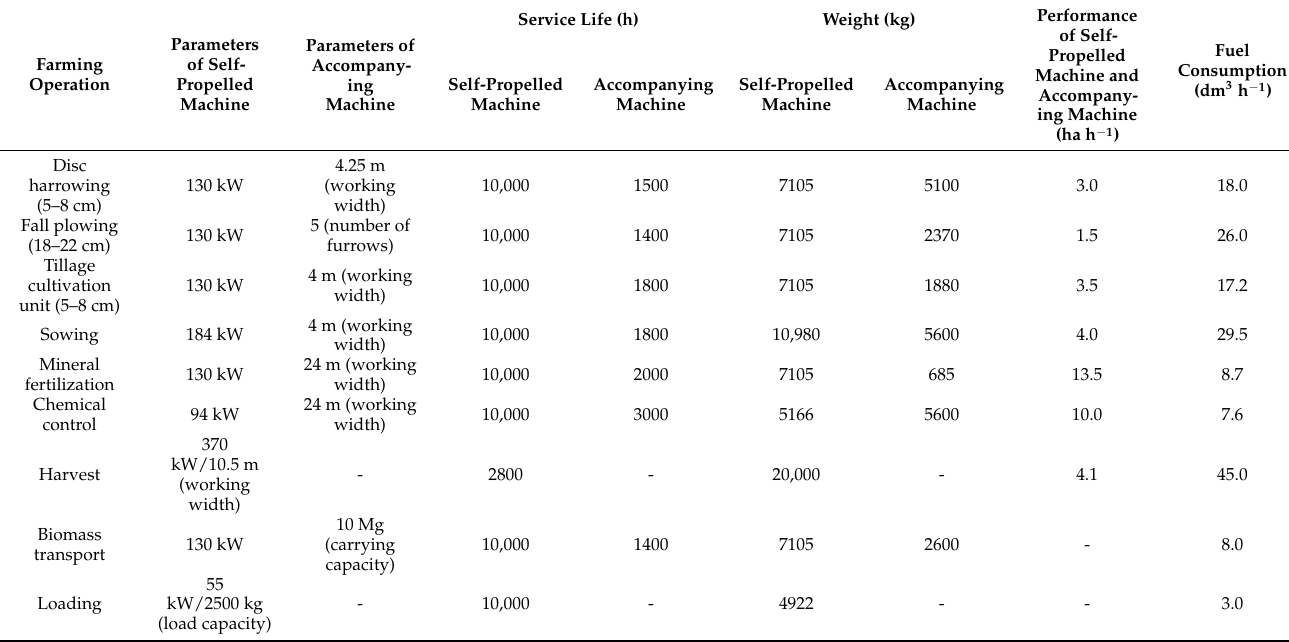
Table 3. Technical parameters, performance and fuel consumption of agricultural machines in the production of winter triticale